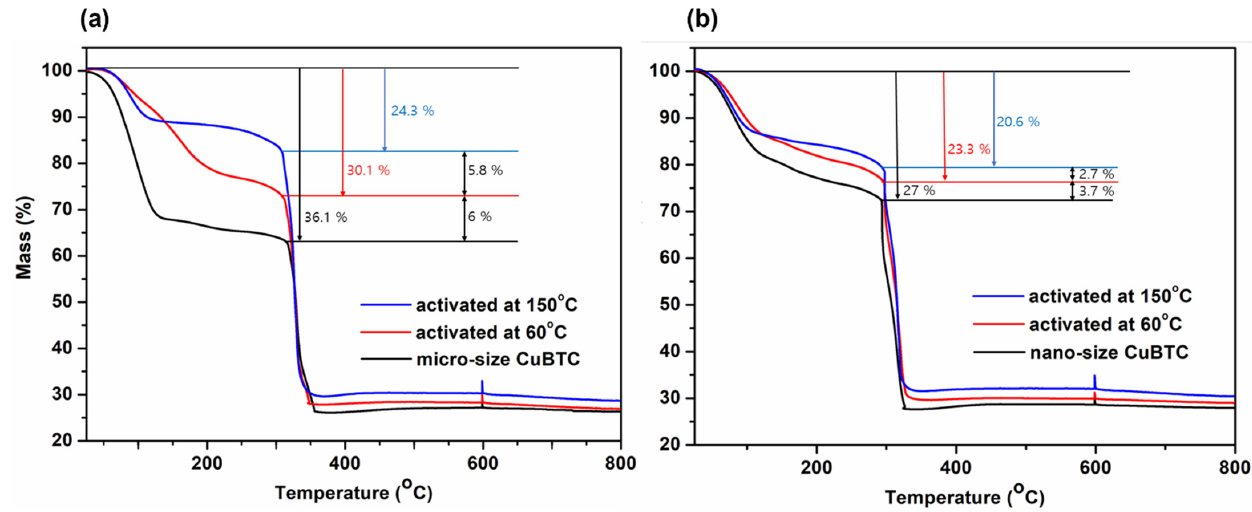
Figure 8. TGA of 1 ( a ) and 2 ( b ) . Black line, as-prepared; red line, activated at 60 °C; blue line, activated at 150 °C. activated at 150 ◦